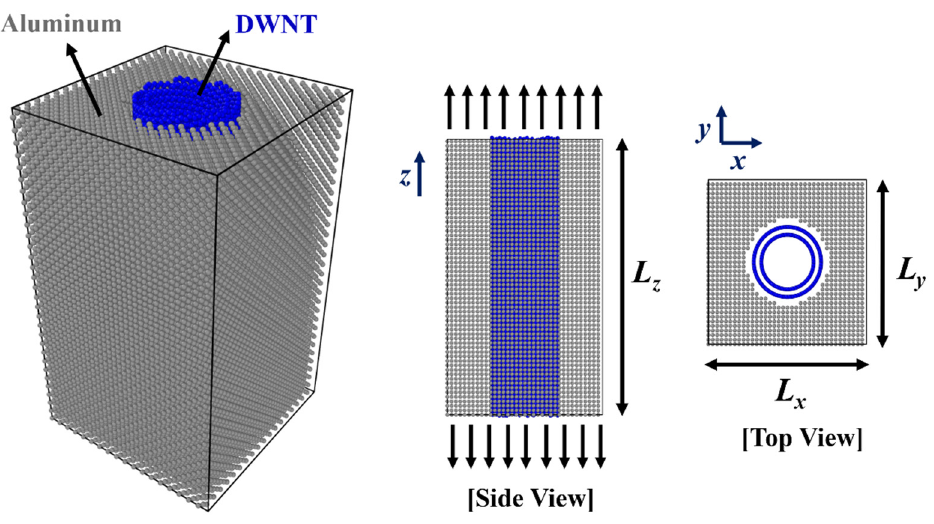
Figure 7. CNT-Al composite RVE for the MD simulations. L z =124.44 Å and L z =97.25 Å for DWNT-Al and SWNT-Al, respectively. L x and L y were adjusted from 44.5 to 89.1 Å according to the CNT volume fraction and CNT size.